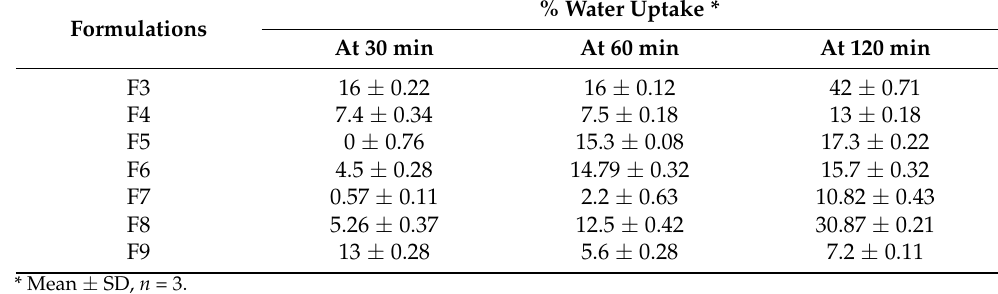
Table 9. Percentage water uptake study results of the oral raft-forming in situ gelling system of NTB.